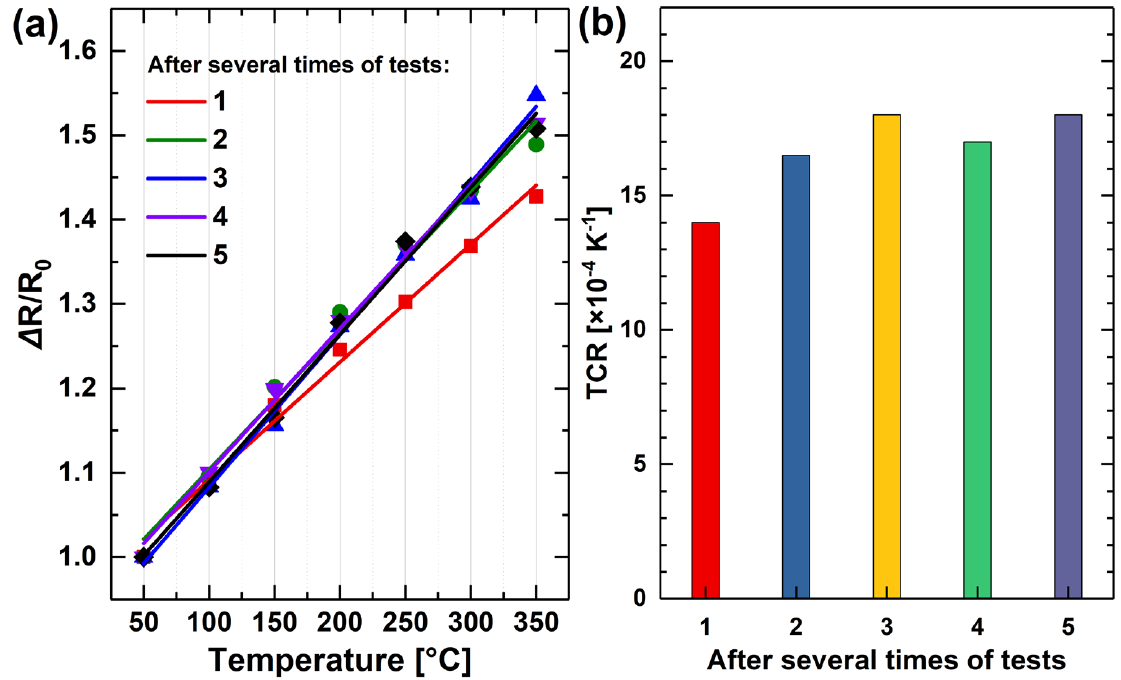
Figure 12. ( a ) Thermal-resistance curves, ( b ) TCR values of annealed WTi alloy film with 6.8 at.% Ti after cycled-thermal-resistance measurements.